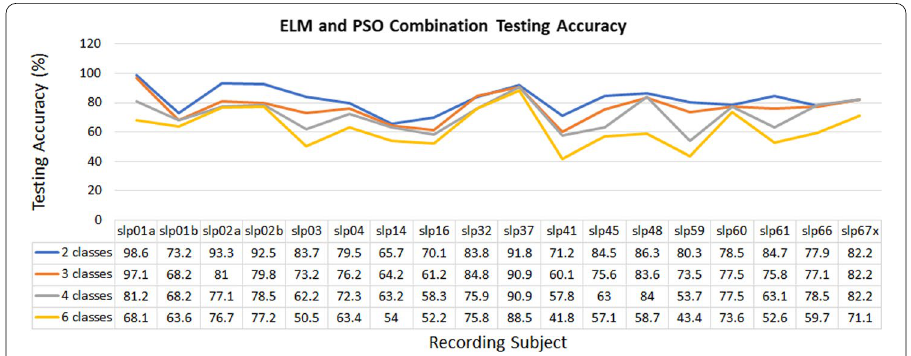
Fig. 5 The testing accuracy of the integration of ELM with PSO in 4 sets of classes